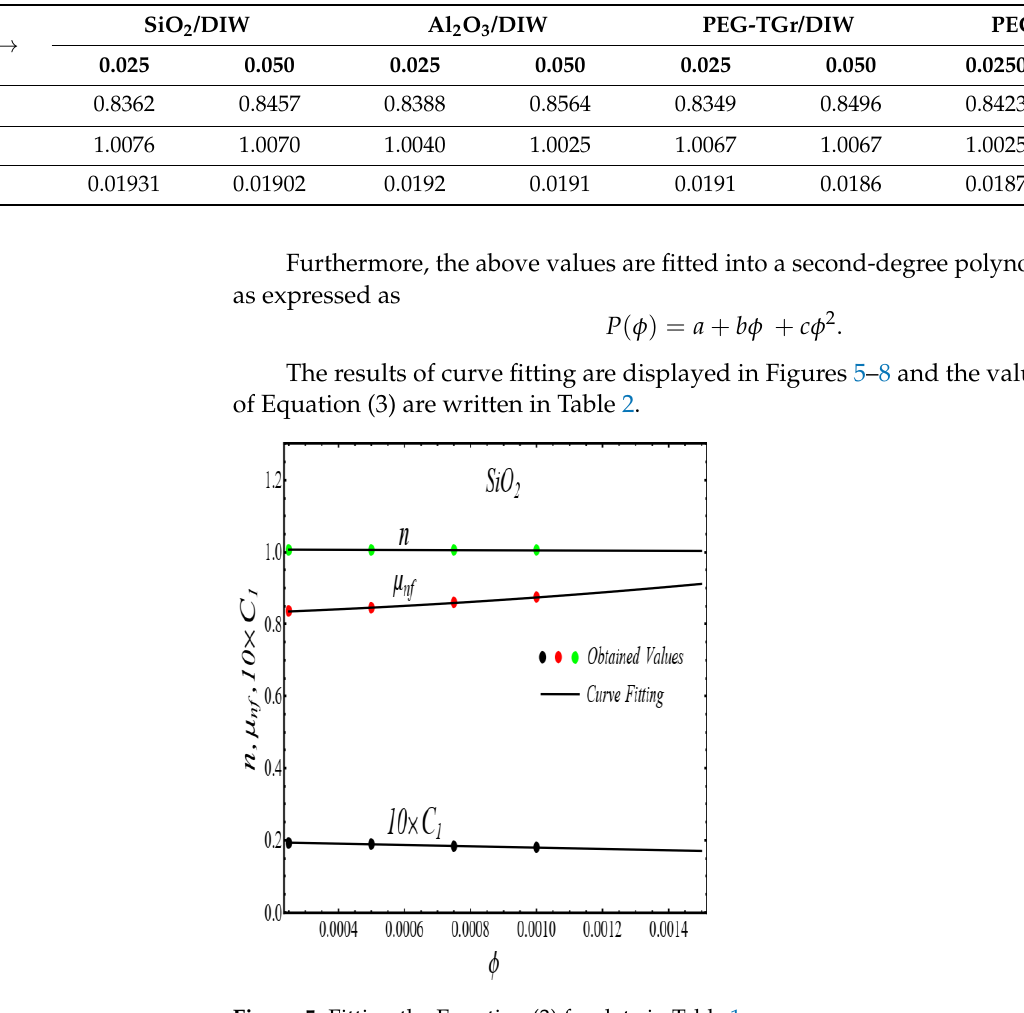
Figure 5. Fitting the Equation (3) for data in Table 1.